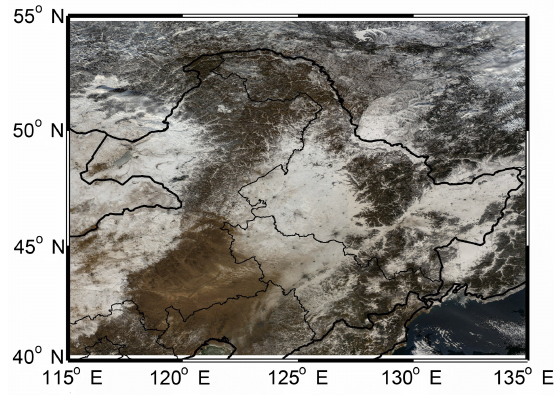
Figure 12. A true color map of MODIS in NEC on 23 January